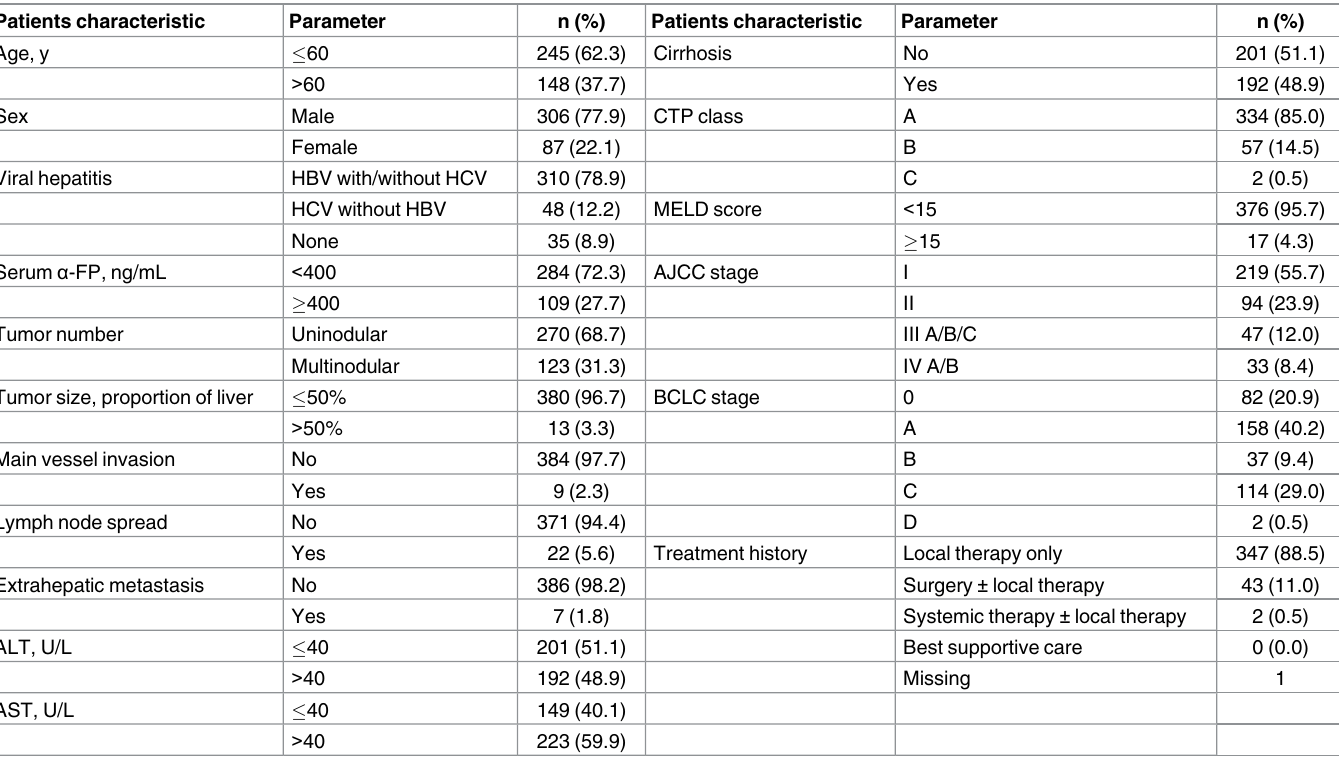
Table 1. Baseline